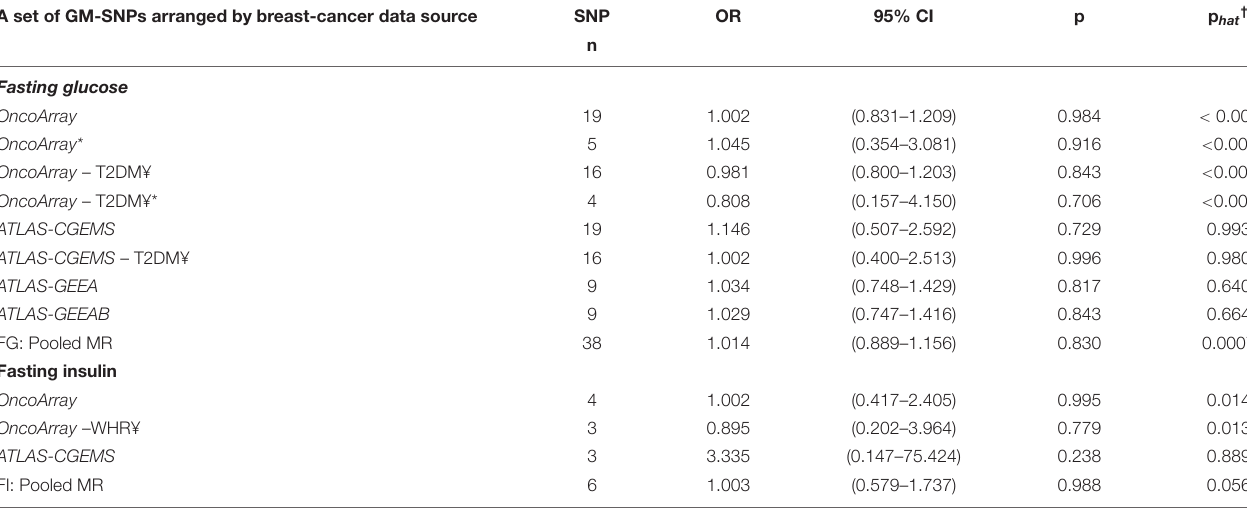
TABLE 2 | Mendelian randomization analysis for the effect of genetically determined glucose-metabolism phenotypes on risk for breast cancer. A set of GM-SNPs arranged by breast-cancer data